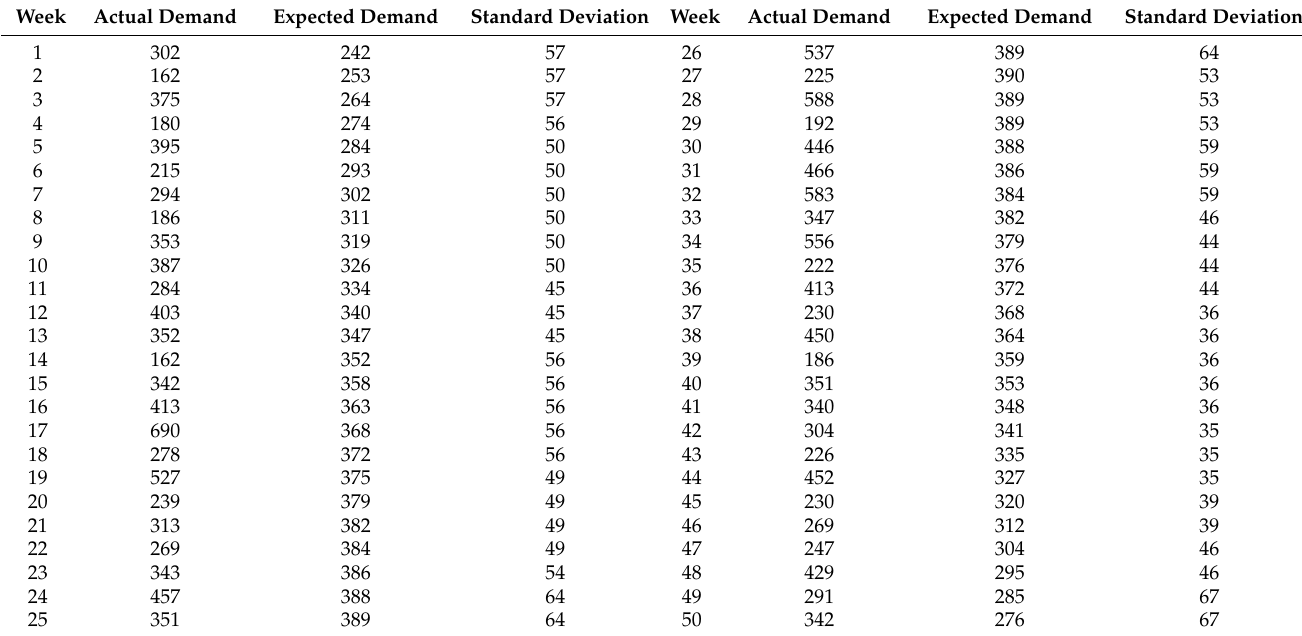
Figure 3. Weekly demand of apple juice with forecasting. The forecasting model performance is not very high. However, it is better than as- suming the demand is stable. In reality, there were 17 deliveries in the year, where each lot is from 500 to 1500 boxes. Assume the following data H = 5$, S = 125$, P 0 = 752, V = 1500, and the detailed demand data is in Table 1. Table 1. Demand information of the apple juice of the drinks’ company in a year .